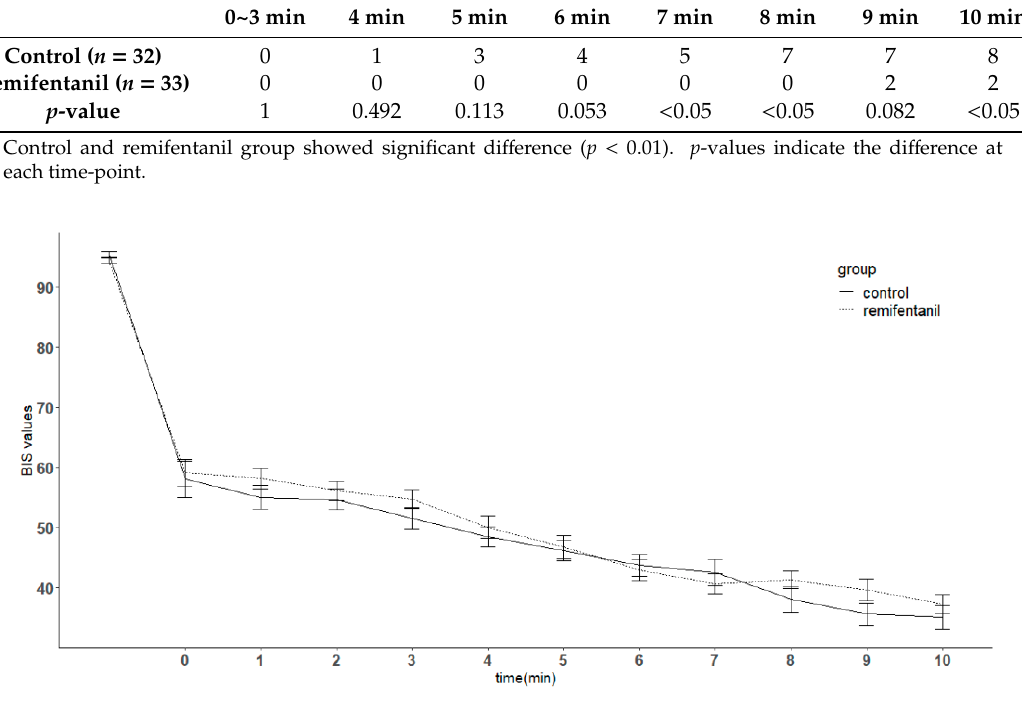
Figure 3. Changes in the burst suppression ratio (BSR) in patients with or without remifentanil infusion. In unconscious patients with propofol at the target effect-site concentration of 5 μ g/mL, a